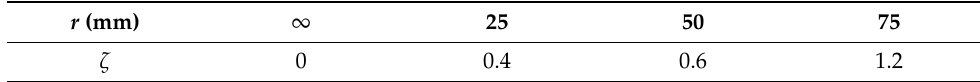
Table 1. Correspondence between ζ and r .